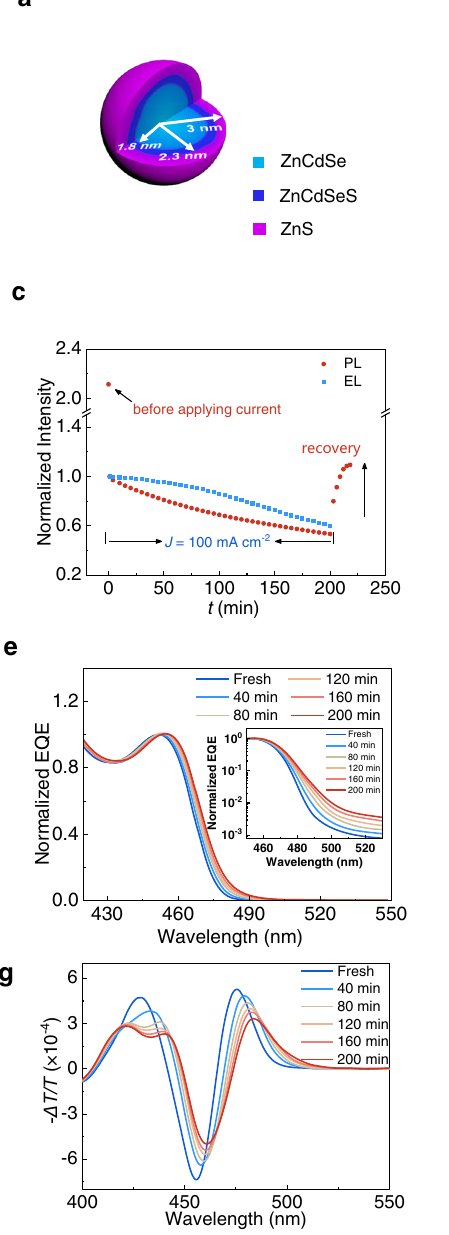
operation time. The current density is set at 100mAcm − 2 . The error bars represent thedatarange. e Sensitiveexternalquantumef fi ciency(sEQE PV )spectraofQ1-based QLEDs. The inset shows the same sEQE PV plotted on a logarithmic scale to demon- stratethenearband-edgetransitions. f Upper:electroabsorptionspectraofQ1-based QLED. Below: Q1 ’ s absorption coef fi cient ( α ) and 2nd derivative of α ( α ″ ). g Time- dependent electroabsorption spectra of Q1-based QLEDs. The devices for time- dependent spectral analysis are aged by a constant current density of 100mAcm − 2